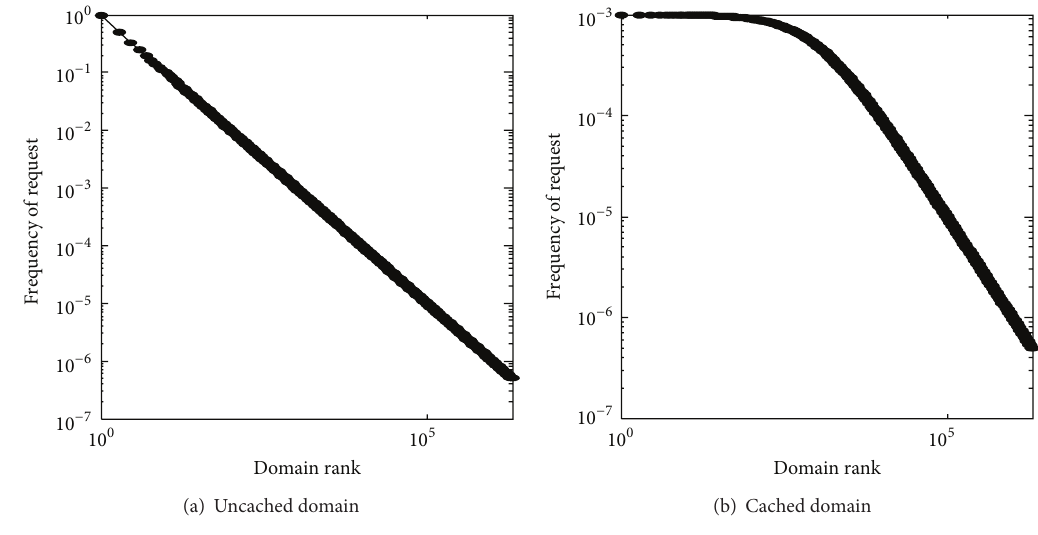
Figure 5: Caching effects on the domain name popularity.